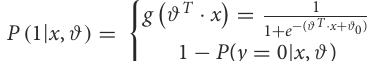
auditorily (headphones with white noise) blind and without any vibratory feedback. In the AFB condition, no vibratory feedback was supplied to the user, but the absence of the headphones permitted accidental auditory feedback of the moving